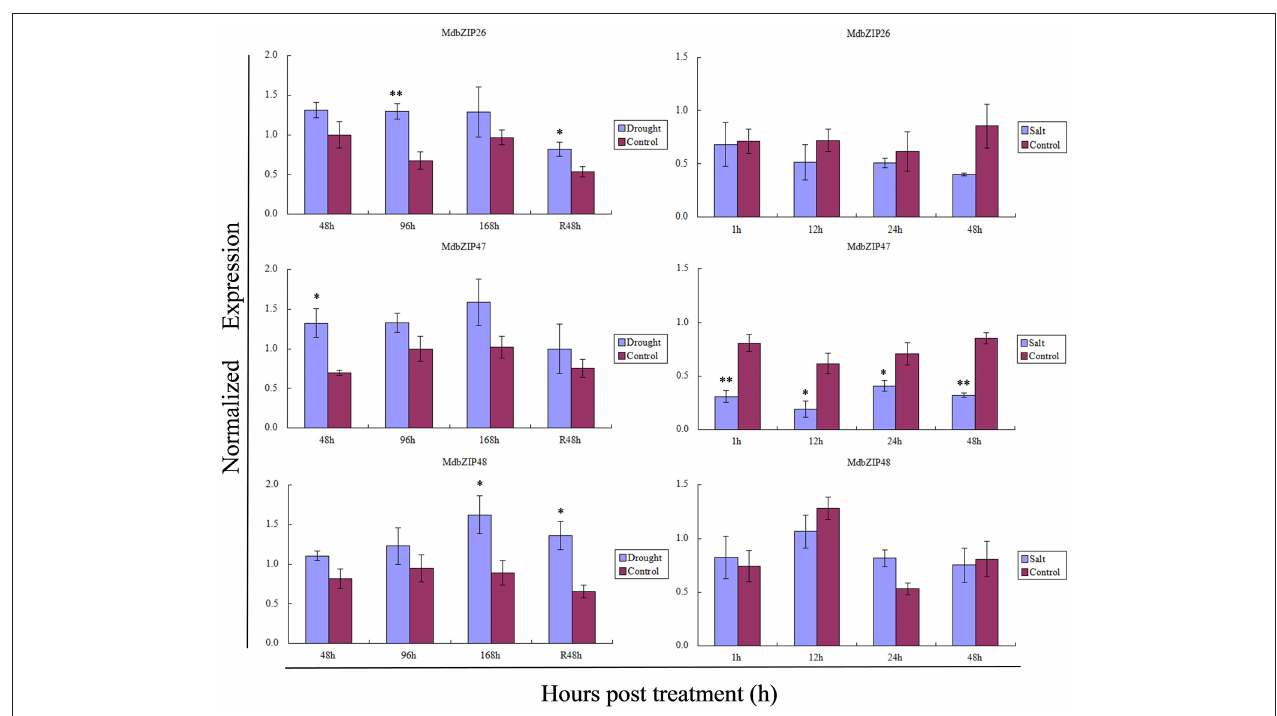
FIGURE 10 | Transcript levels in leaves of three randomly selected MdbZIP genes (MdbZIP26, MdbZIP47, MdbZIP48) following drought and salinity stress treatments, determined by quantitative real-time RT-PCR. The apple EF-1a gene was used as an internal control to normalize the data. The error bars were calculated based on three biological replicates. The data are shown as the mean values ± SD. Asterisks represents the corresponding gene signifcantly up- or down-regulated under the differential treatment by t -test ( * P < 0.05, ** P <